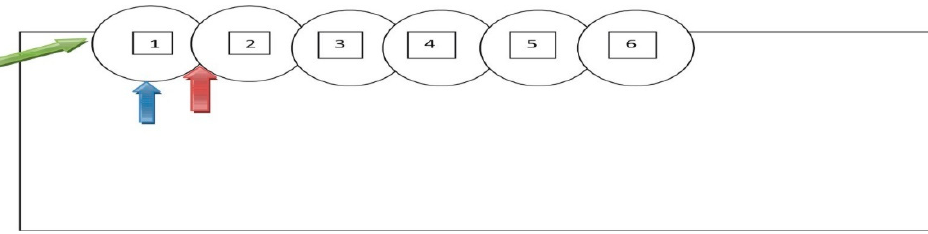
Figure 11. Places in HAZ where structural components were assessed.